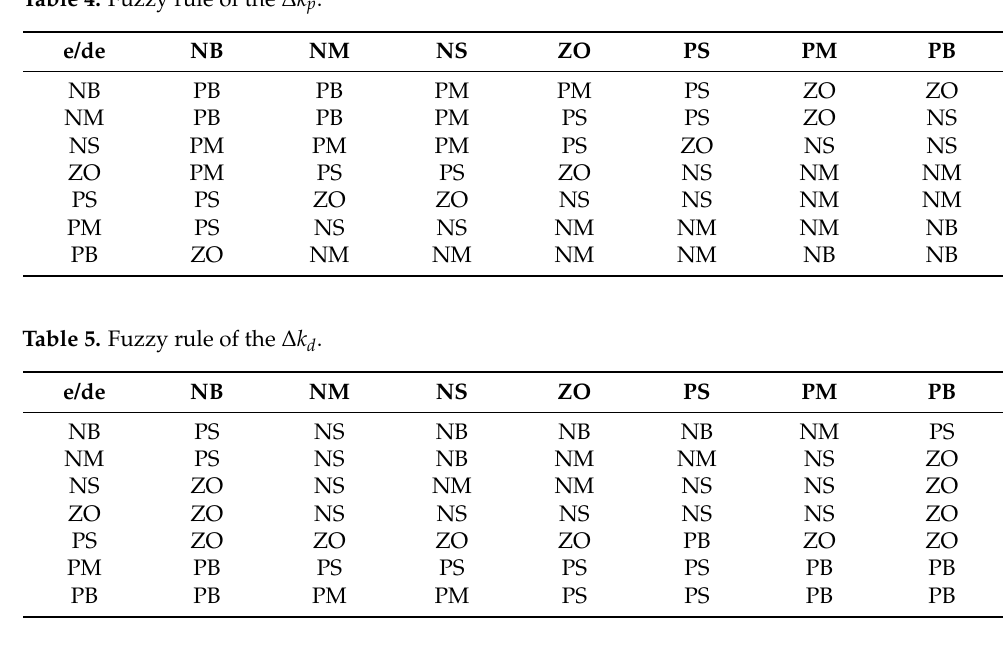
Table 4. Fuzzy rule of the ∆ k p .